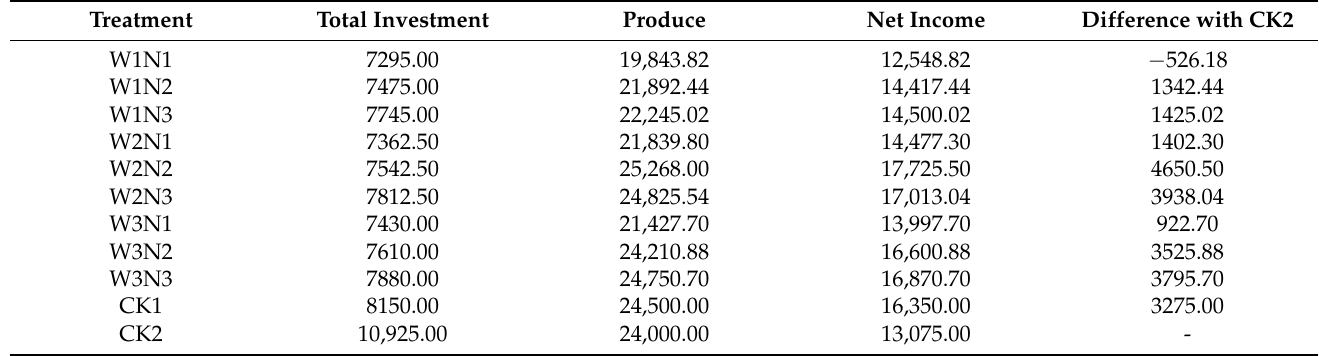
Table 4. Input and output analysis of shallow drip irrigation and traditional border irrigation (RMB · ha − 1